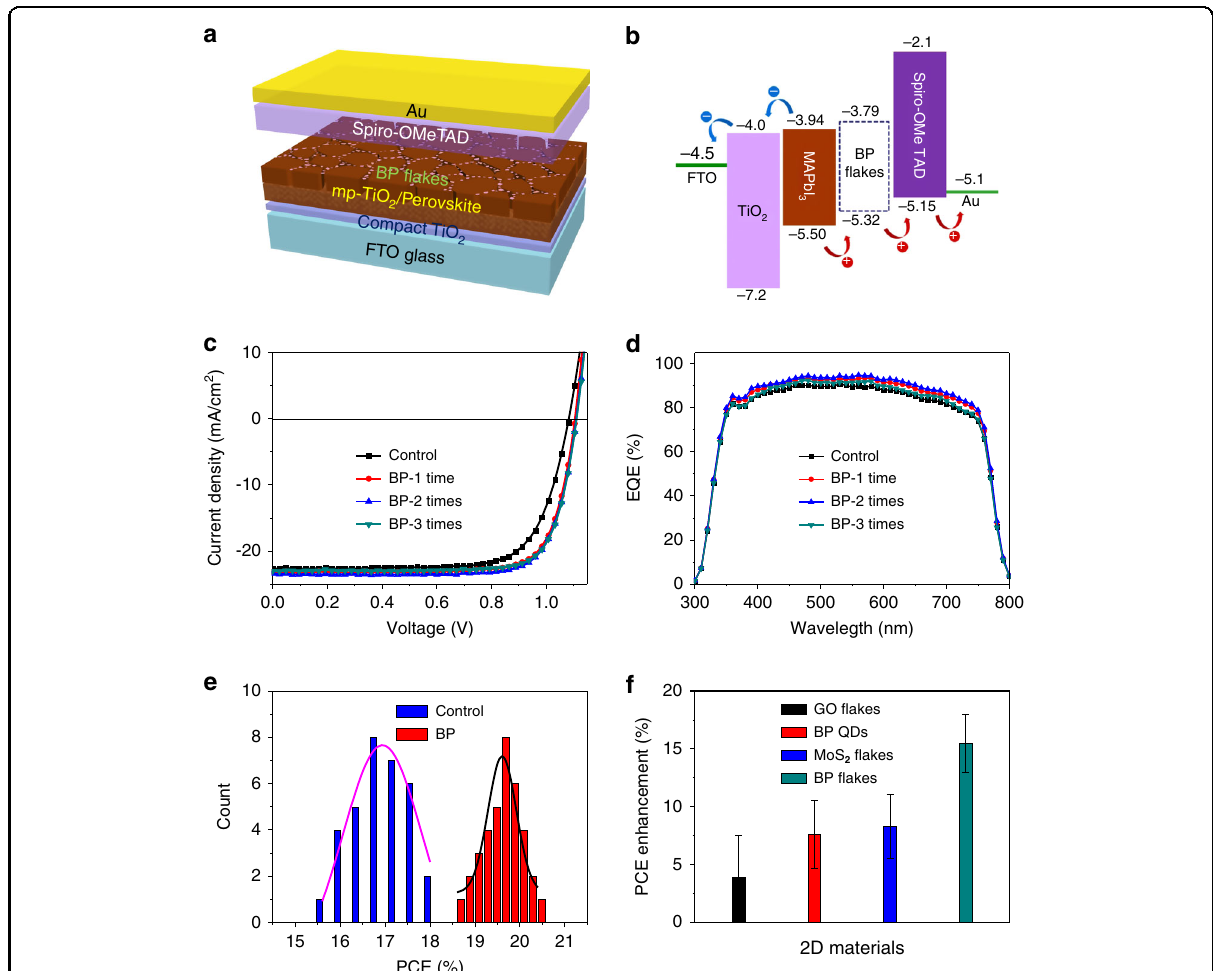
Fig. 1 Device structure and photovoltaic performance of MAPbI 3 PSCs. a , b Structural schematic diagram and energy-level band diagram of a BP-modi fi ed PSC with a normal structure. c , d Current density – voltage ( J – V ) curves (reverse scan) and external quantum ef fi ciency (EQE) spectra of PSCs without (control) and with BP (1 – 3 times) deposited on the perovskite fi lm surface. e Histogram of the power conversion ef fi ciencies (PCEs) of PSCs without (control) and with the BP modi fi cation (2 coats of BP). The PCEs are derived from the reverse scans of the J – V curves. f Average PCE enhancement after the modi fi cation of perovskite fi lms with different 2D materials. The error bar corresponds to the standard error for 30